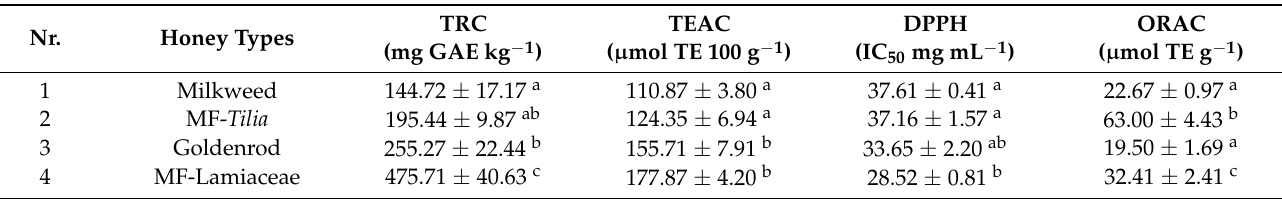
Table 3. Total antioxidant capacities of the honey